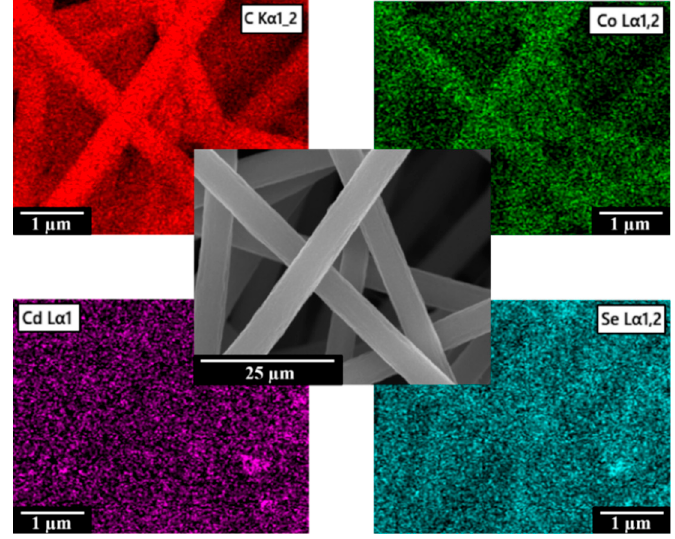
Figure 3. Elemental mapping of Co-CdSe@ECNFs.